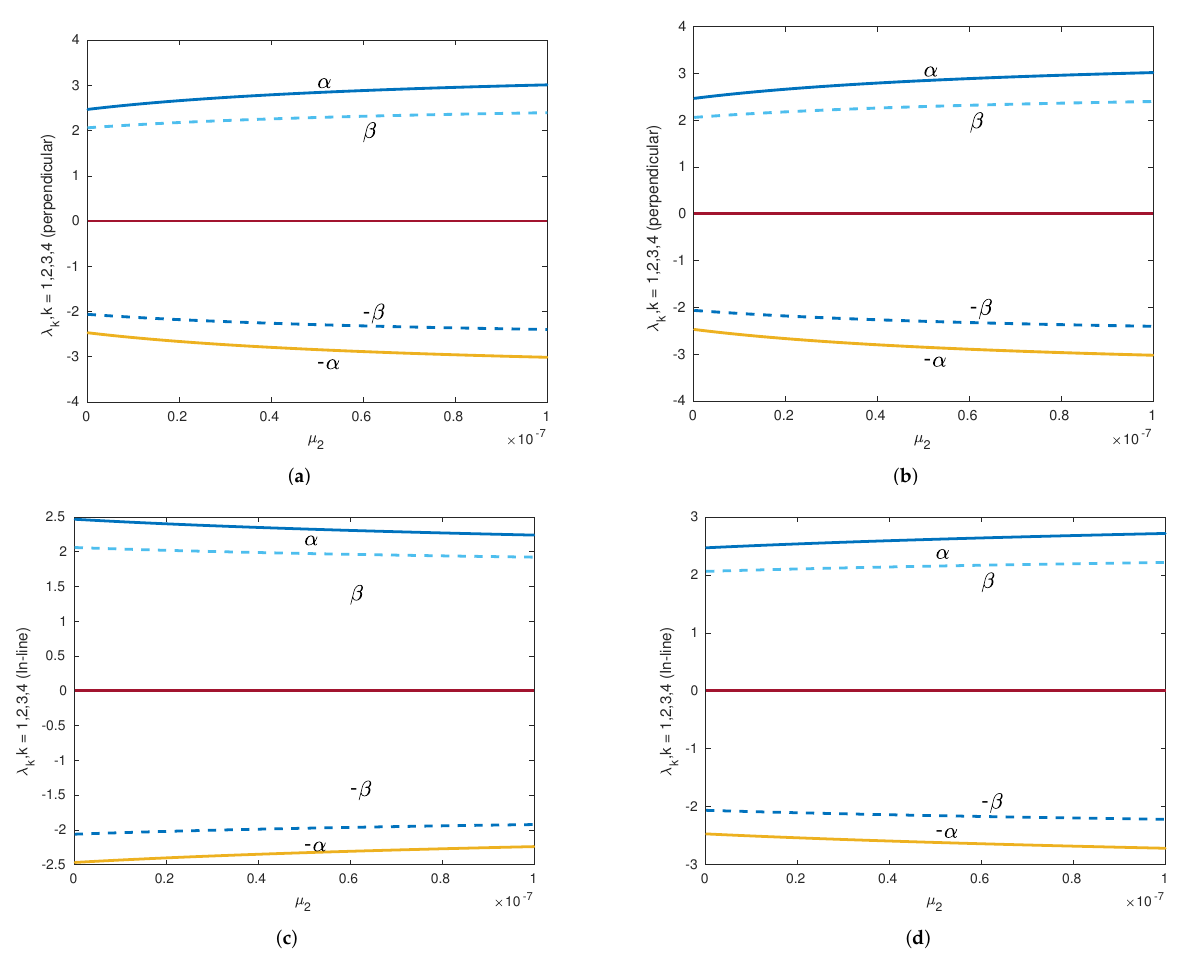
Figure 9. Eigenvalues versus µ 2 ∈ ( 10 − 10 ,10 − 7 ) of the Sun–Saturn system in the presence of the Kuiper belt effect near L 5 equilibrium point with µ 1 = 10 − 7 . Continuous lines denote the real part of the eigenvalues, and dashed lines denote the imaginary parts of the eigenvalues for collinear points. ( a ) Eigenvalues of perpendicular equilibrium point near L 5 toward smaller primary. ( b ) Eigenvalues of perpendicular equilibrium point near L 5 away from smaller primary. ( c ) Eigenvalues of inline equilibrium point near L 5 away from center. ( d ) Eigenvalues of inline equilibrium point near L 5 toward